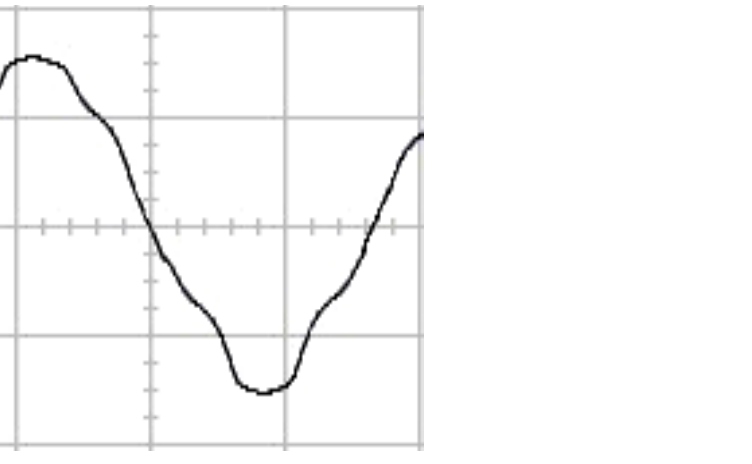
Figure 18. Experimental AC output voltage for the traditional SMRL under rectifier load (vertical: 100 V/div and 5 ms/div).